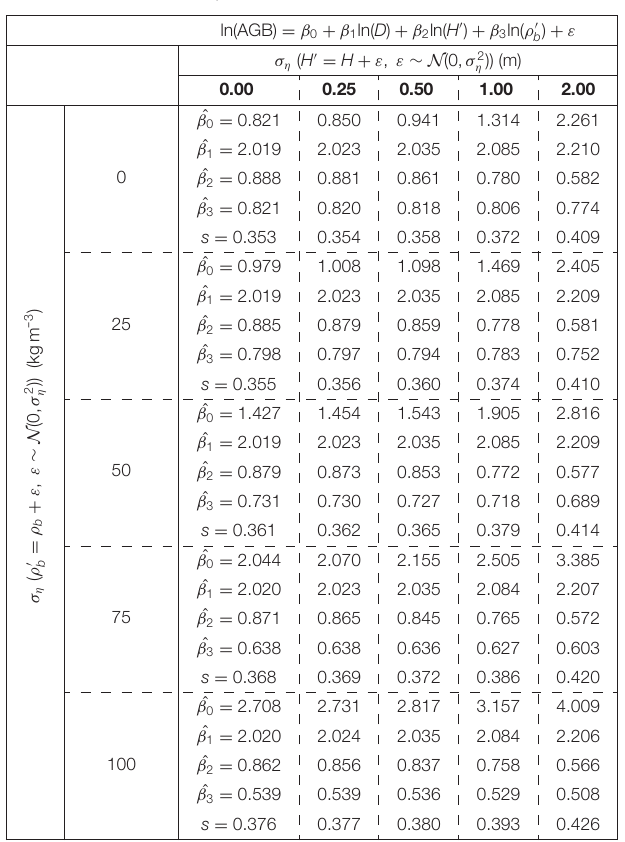
TABLE 6 | Simulating inconsistent measurement error in predictor variables between in- and out-of-sample